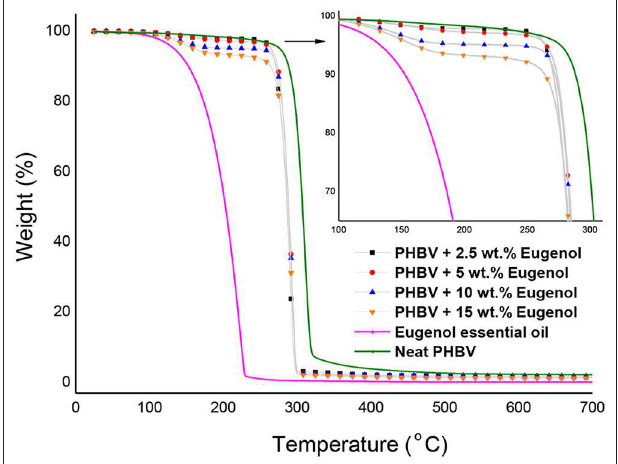
FIGURE 5 | Thermogravimetric analysis (TGA) curves of eugenol and electrospun monolayers of poly(3-hydroxybutyrate- co -3-hydroxyvalerate) (PHBV) containing eugenol.